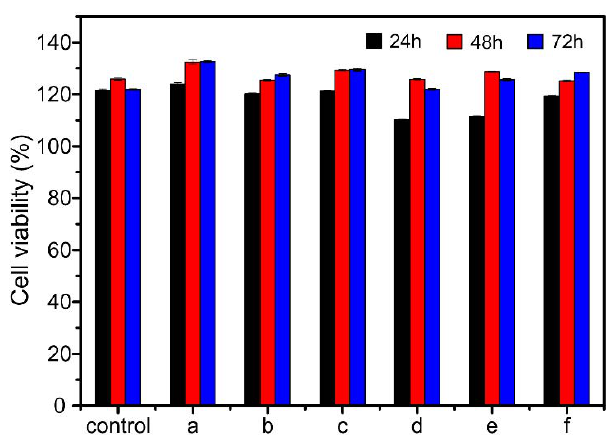
Figure 9. Viability of melanoma cells (MCs) incubated without and with drug ‐ loaded nanofibrous membranes: ( a ) CS/PVA nanofibrous membrane, ( b ) CS/PVA/GO nanofibrous membrane, ( c ) CS/PVA/CipHcl nanofibrous membrane, ( d ) CS/PVA/GO/CipHcl nanofibrous membrane, ( e ) CS/PVA/Cip nanofibrous membrane, ( f ) CS/PVA/GO/Cip nanofibrous membrane ( p * <